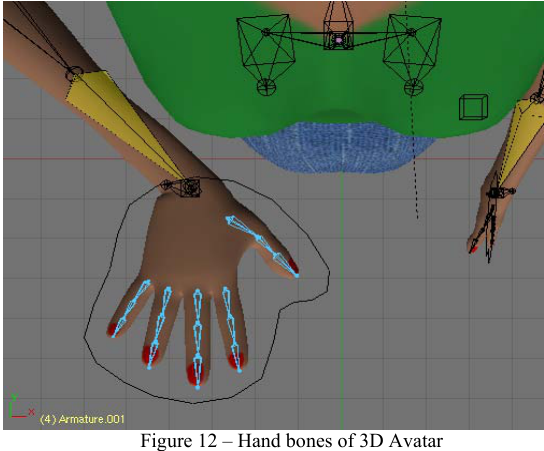
Figure 12 – Hand bones of 3D Avatar